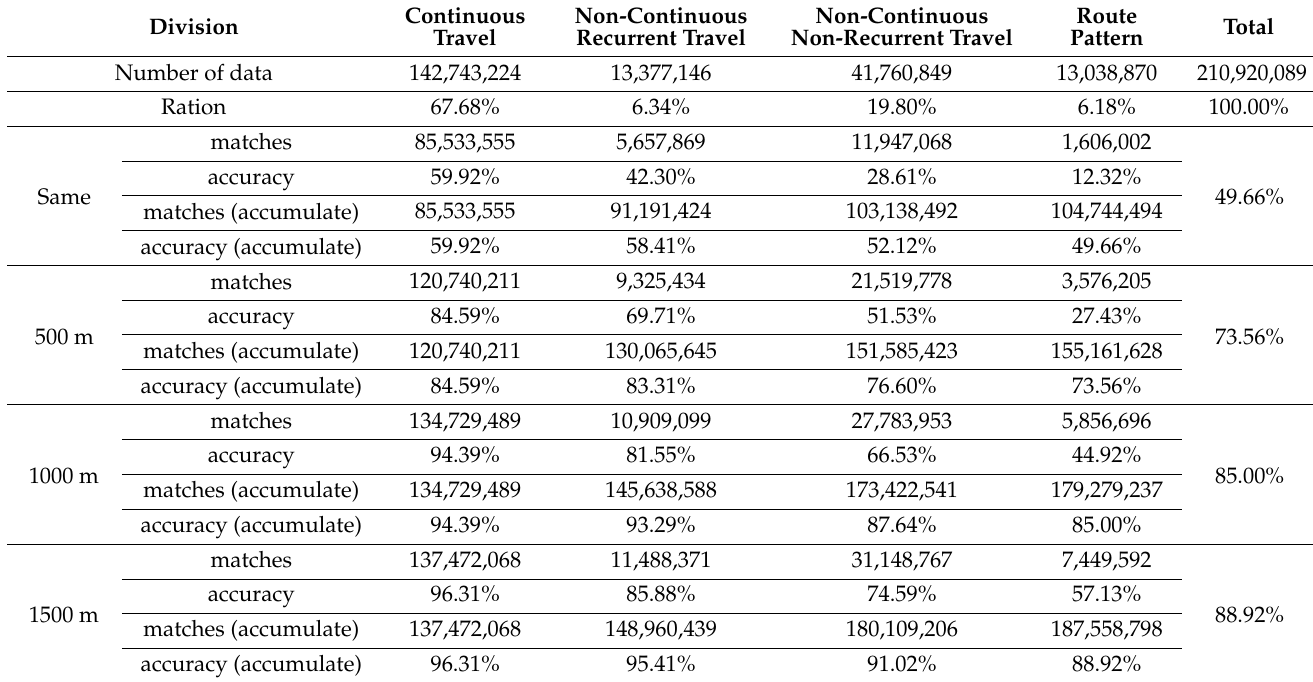
Table 5. Estimated results of destination by trip type